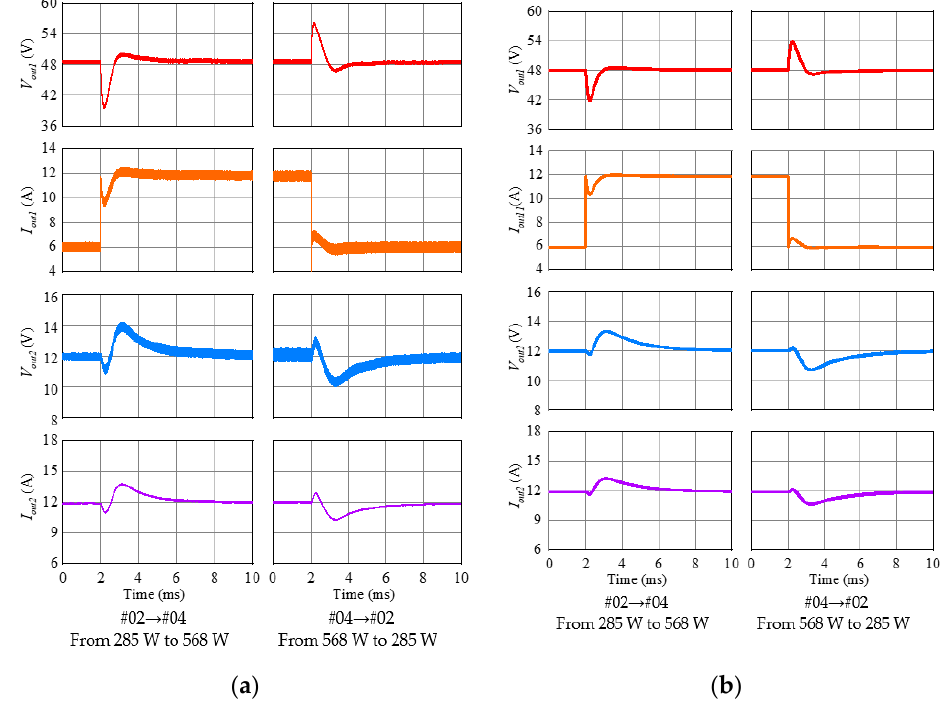
Figure 17. Results of P out 1 dynamic response test when P out 2 = 140 W: ( a ) Experimental results; ( b )